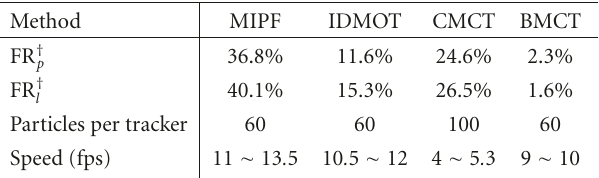
Table 3: Quantitative performance and speed